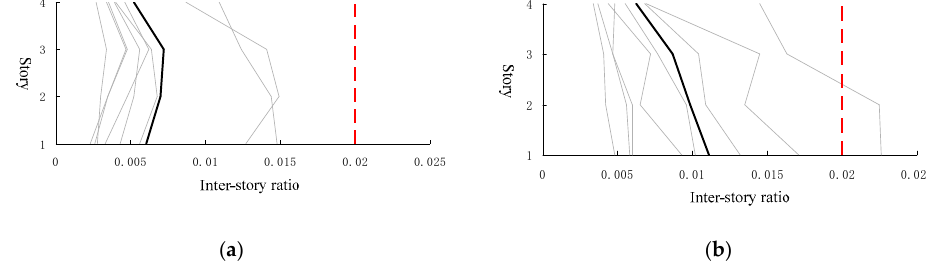
Figure 18. Inter-story drift responses of both structures ( PGA = 0.31 g). ( a ) The dual structure; ( b ) The bare frame structure.